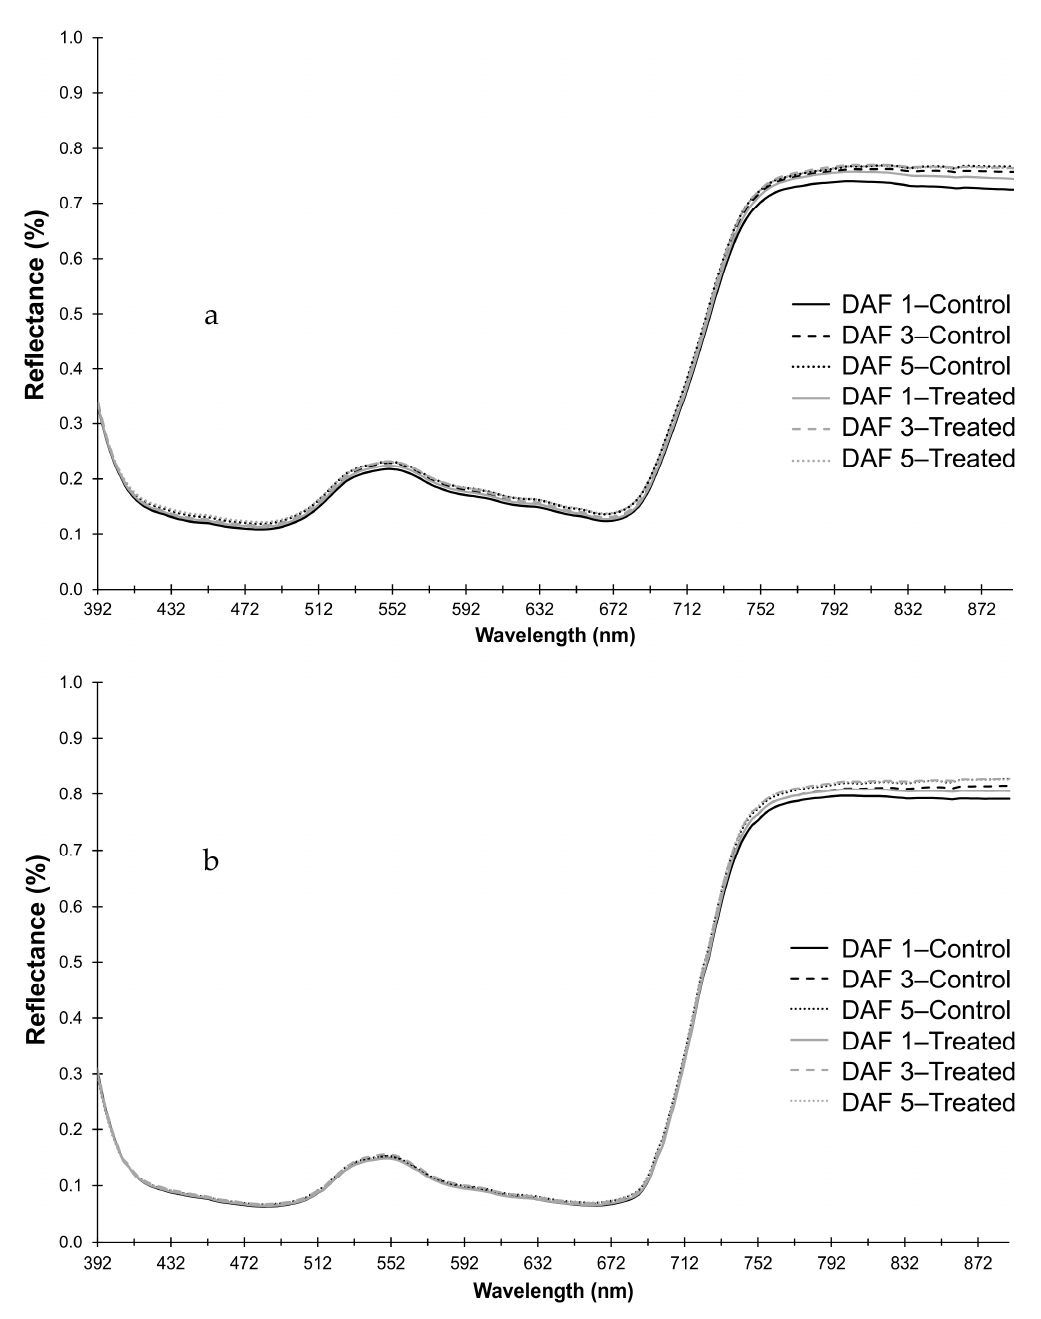
Figure 2. Predicted mean reflectance for R 392-889 for the model for ( a ) heads and ( b ) leaves for frost treated (treatment) and control plants from 1, 3 and 5 days after frost (DAF).